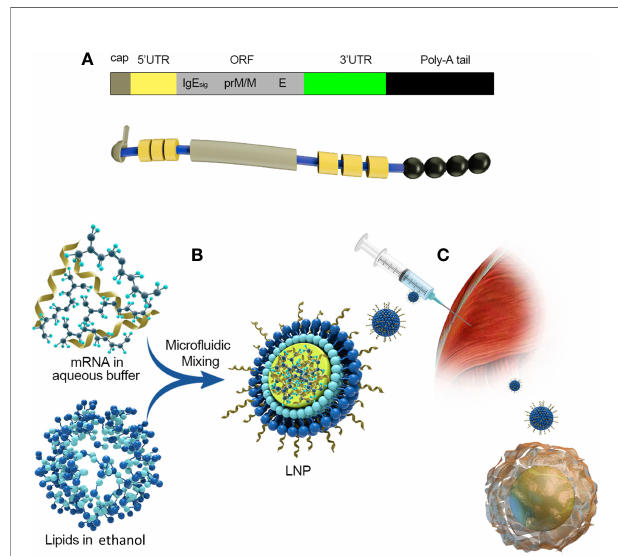
FIGURE 5 | Take Moderna ’ s mRNA vaccine against the zika virus as an example. (A) The composition of mRNA:(1) cap:m7G (2) 5 ’ UTR: Including Kozak consensus sequence (3) ORF: It consists of a signal peptide sequence and a sequence encoding PRM/M and E protein of zika virus, and 1-methyl- pseudo UTP is used instead of UTP (4) 3 ’ UTR:3 ’ UTR of human alpha globin (5) poly(A):30bp. (B) A schematic diagram of the process of encapsulating mRNA into LNPs. (C) Intramuscular injection and antigen